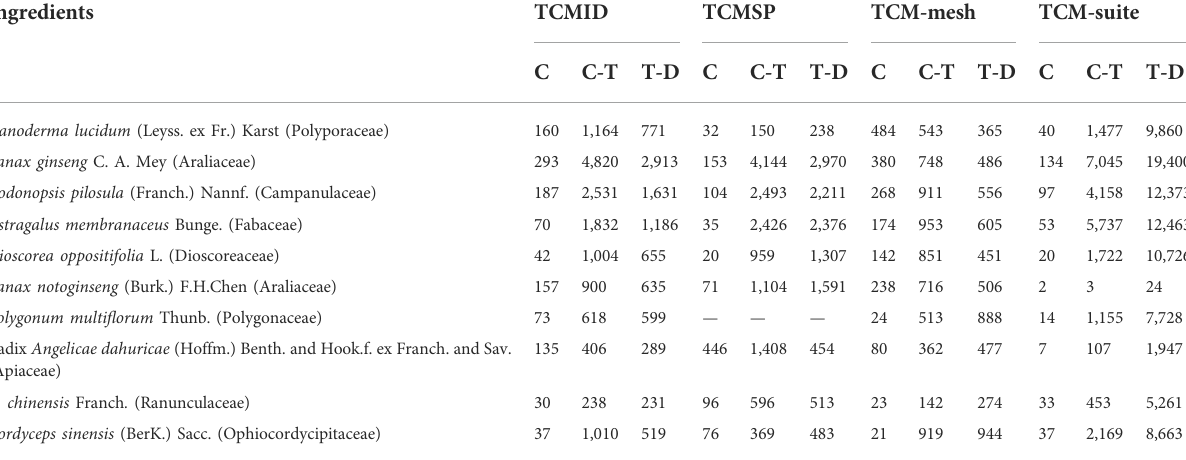
TABLE 2 Comparing the properties of four representative TCM databases based on the selected ingredients reported in the previous study (Zhang R. et al., 2019b).